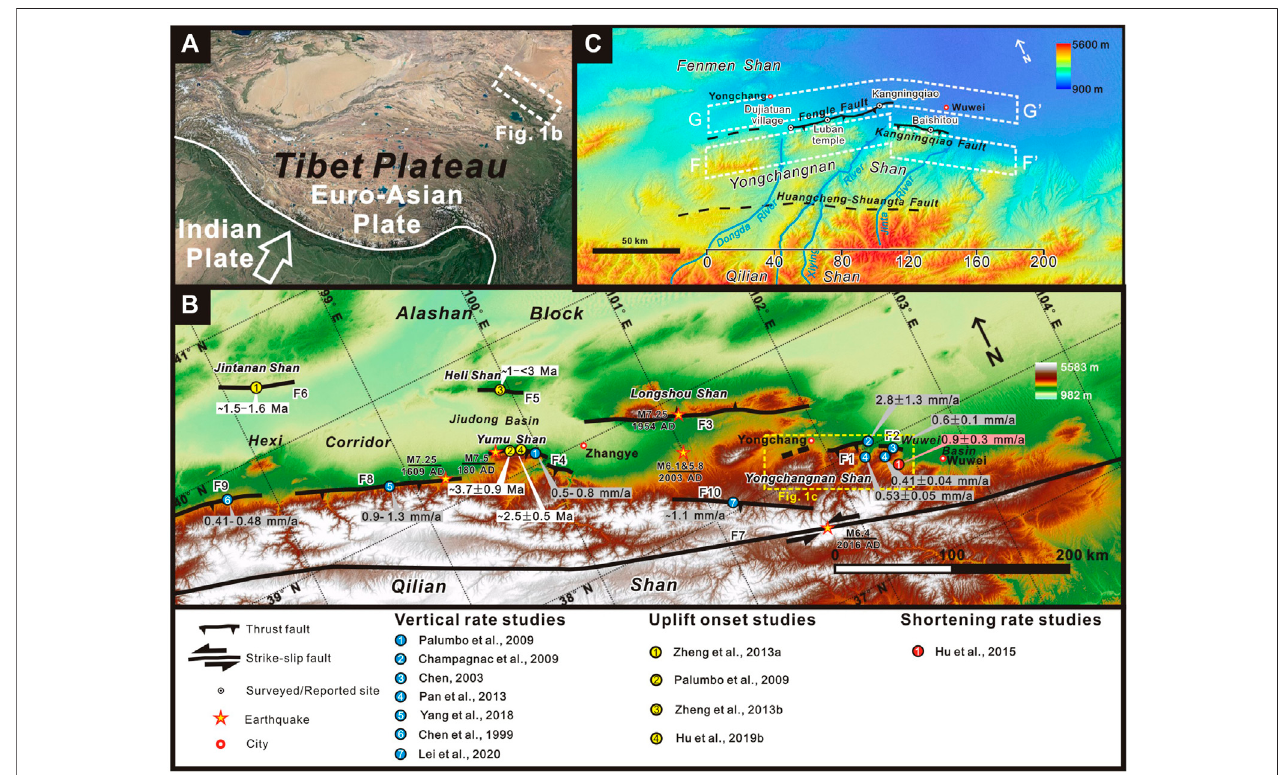
FIGURE 1 | (A) Satellite image shows the study area locates at the northeastern margin of the Tibet plateau. (B) The tectonics in the region: F1, Fengle Fault; F2, Kangningqiao Fault; F3, Longshoushan Fault; F4, Yumushan Fault; F5, Helishan Fault; F6, Jintananshan Fault; F7, Haiyuan fault; F8, Fodongmiao-Hongyazi Fault; F9, Yumen Fault; F10, Minle-Damaying fault. Blue circles show locations of previous vertical slip rate studies. Yellow circles show locations of uplift onset studies. Red circle shows the location of crustal shortening study. (C) Fengle Fault. The white circles show the locations of surveyed